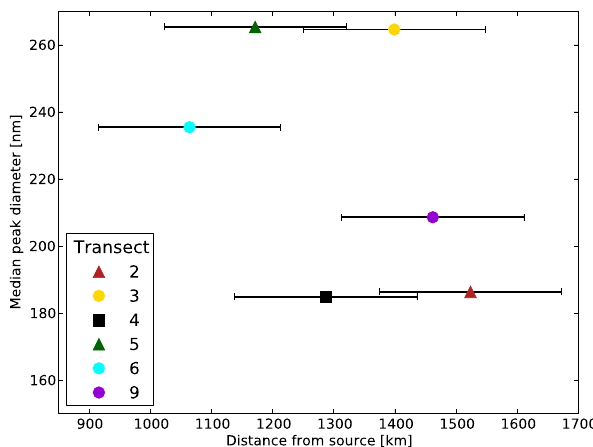
Figure 4. Accumulation-mode peak diameter by transect (2–6, 9) showing no significant trend with plume transport distance. All colours are the same as in Fig. 3. Distance from fire sources was estimated using transect midpoints and approximate source region area. Transects 1, 7 and 8 have insufficient accumulation-mode plume data and have been omitted. The uncertainty bars show un- certainty in the distance from the source ( ±